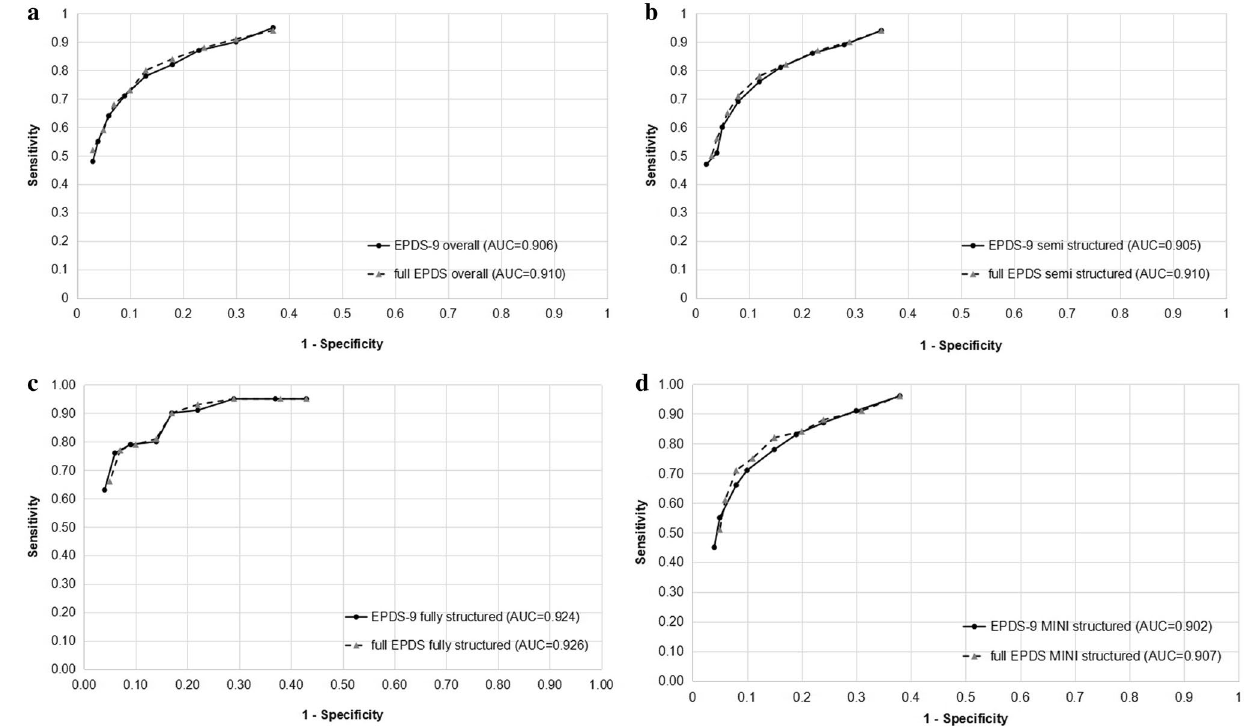
Figure 1. ( a )–( d ) ROC curves for the EPDS-9 and full EPDS ( a ) compared to all reference standards, ( b ) compared to a semi-structured reference standard, ( c ) compared to a fully structured reference standard (MINI excluded), and ( d ) compared to the MINI reference standard.